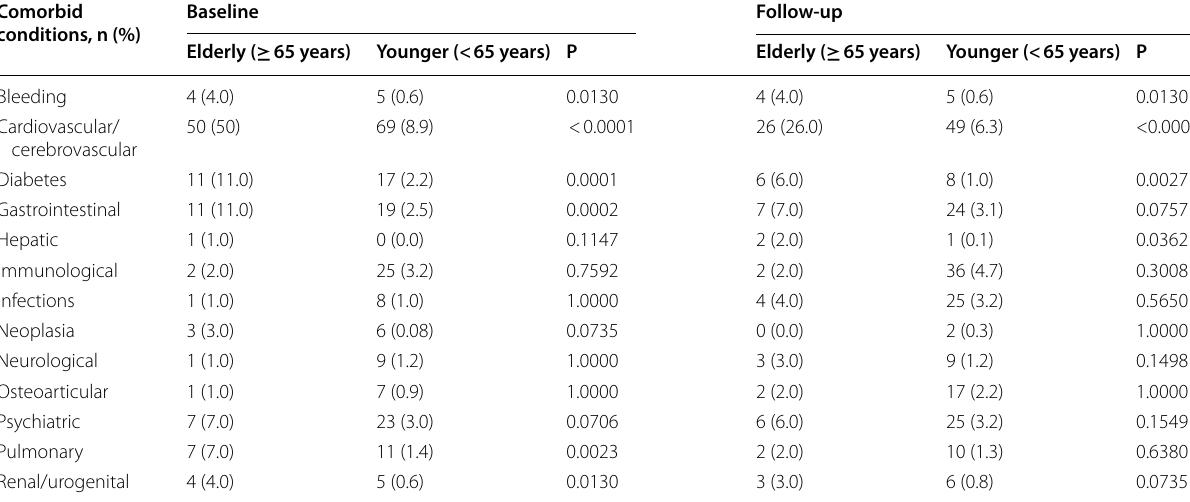
Table 2 Select comorbid conditions at baseline and follow-up